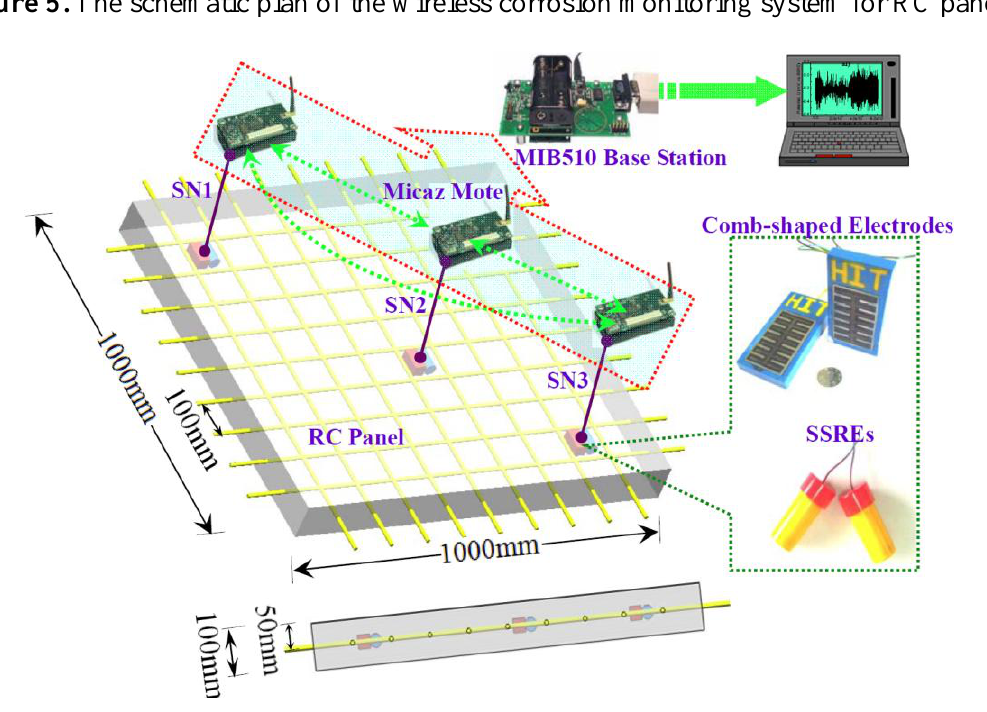
Figure 5. The schematic plan of the wireless corrosion monitoring system for RC